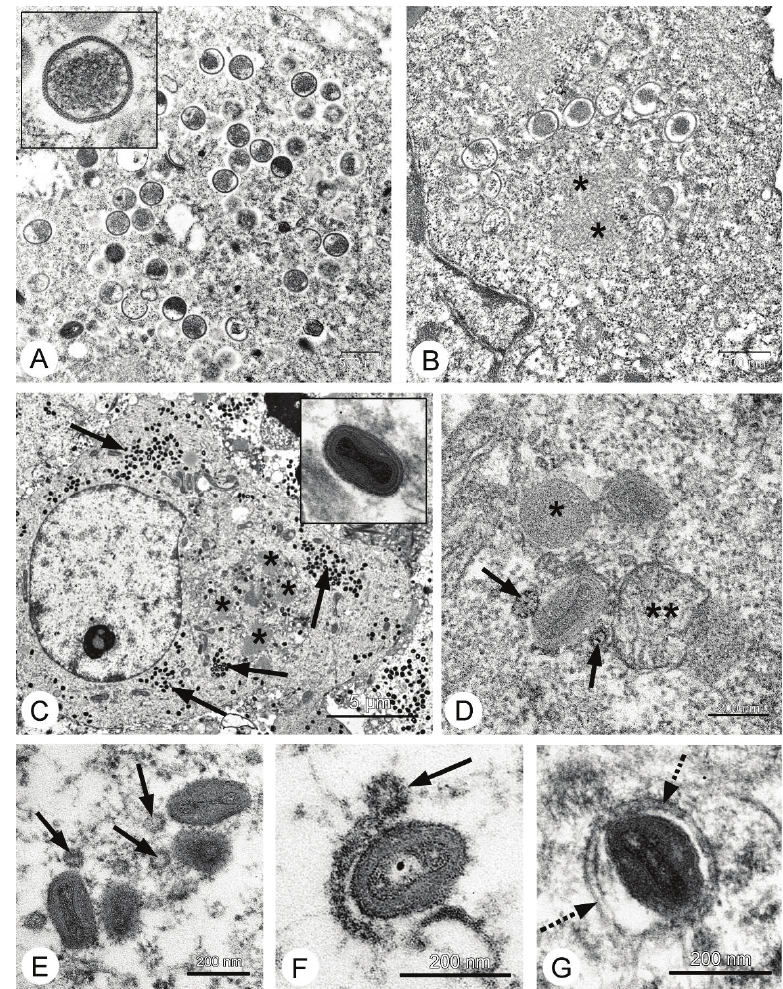
Figure 3. Replication of the L-IVP strain of VACV in cells of human A431 carcinoma ( A , C , E – G ) and murine Ehrlich ascitic carcinoma ( B , D ) cells. Photos A , B show the formation of immature virus particles, the insert in A shows a virion at high magnification, the asterisks show a viroplasm. Photo C shows infected cell containing viroplasm (*) and accumulations of mature virions (shown by arrows), the insert for C shows a mature virion at large magnification. Photos D – G show sequential steps of formation of “enveloped” virions. The arrows show Golgi-derived vesicles, which fuse and thereby form double-membrane envelope (shown by dotted arrow). The asterisk on photo D shows immature virion, the double asterisks show mitochondria.